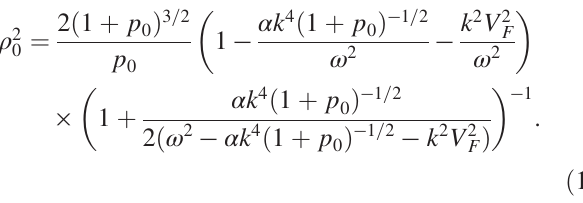
Figure 1 denotes a comparison for the self-focusing